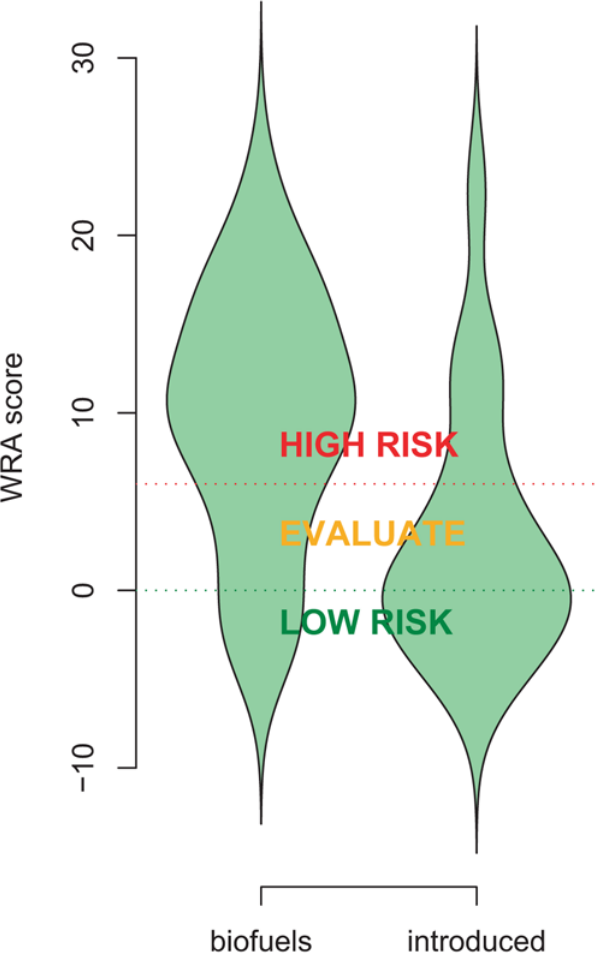
Figure 1. Density distributions of WRA scores of biofuels compared to a random selection of other introduced species; scores were significantly different (Wilcoxon exact test W=1135.5 p , 0.001).